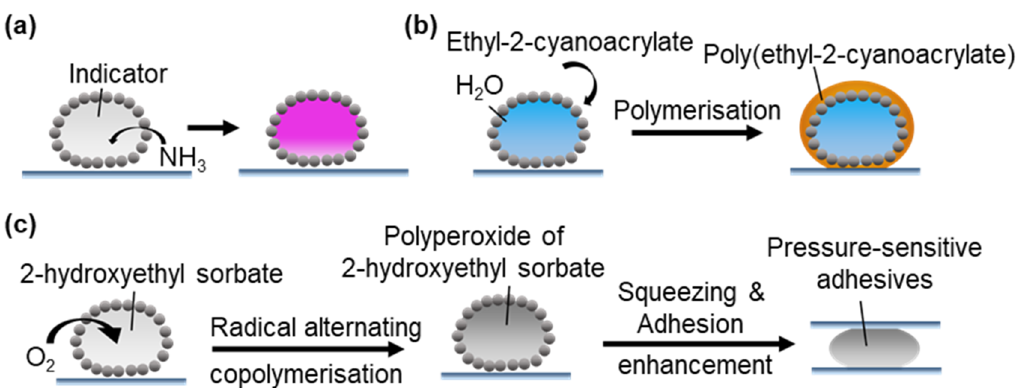
Figure 3. Gas-phase reaction in liquid marbles. ( a ) Colour change of liquid marbles containing an indicator when interacting with a NH 3 vapour [55] . ( b ) Polymerisation of ethyl-2-cryanoacrylate on the surface of coating particles [59] . ( c ) Copolymerisation of 2-hydroxyethyl sorbate (HES) and oxygen to produce pressure-sensitive adhesive using liquid marble-based microreactors [60,61].